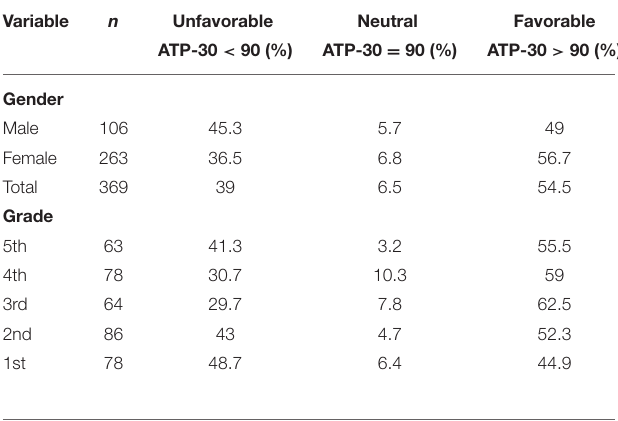
TABLE 1 | Demographic Characteristics of participants ( n = 369). TABLE 2 | Global ATP-30 scores by gender and grade ( n = 369).